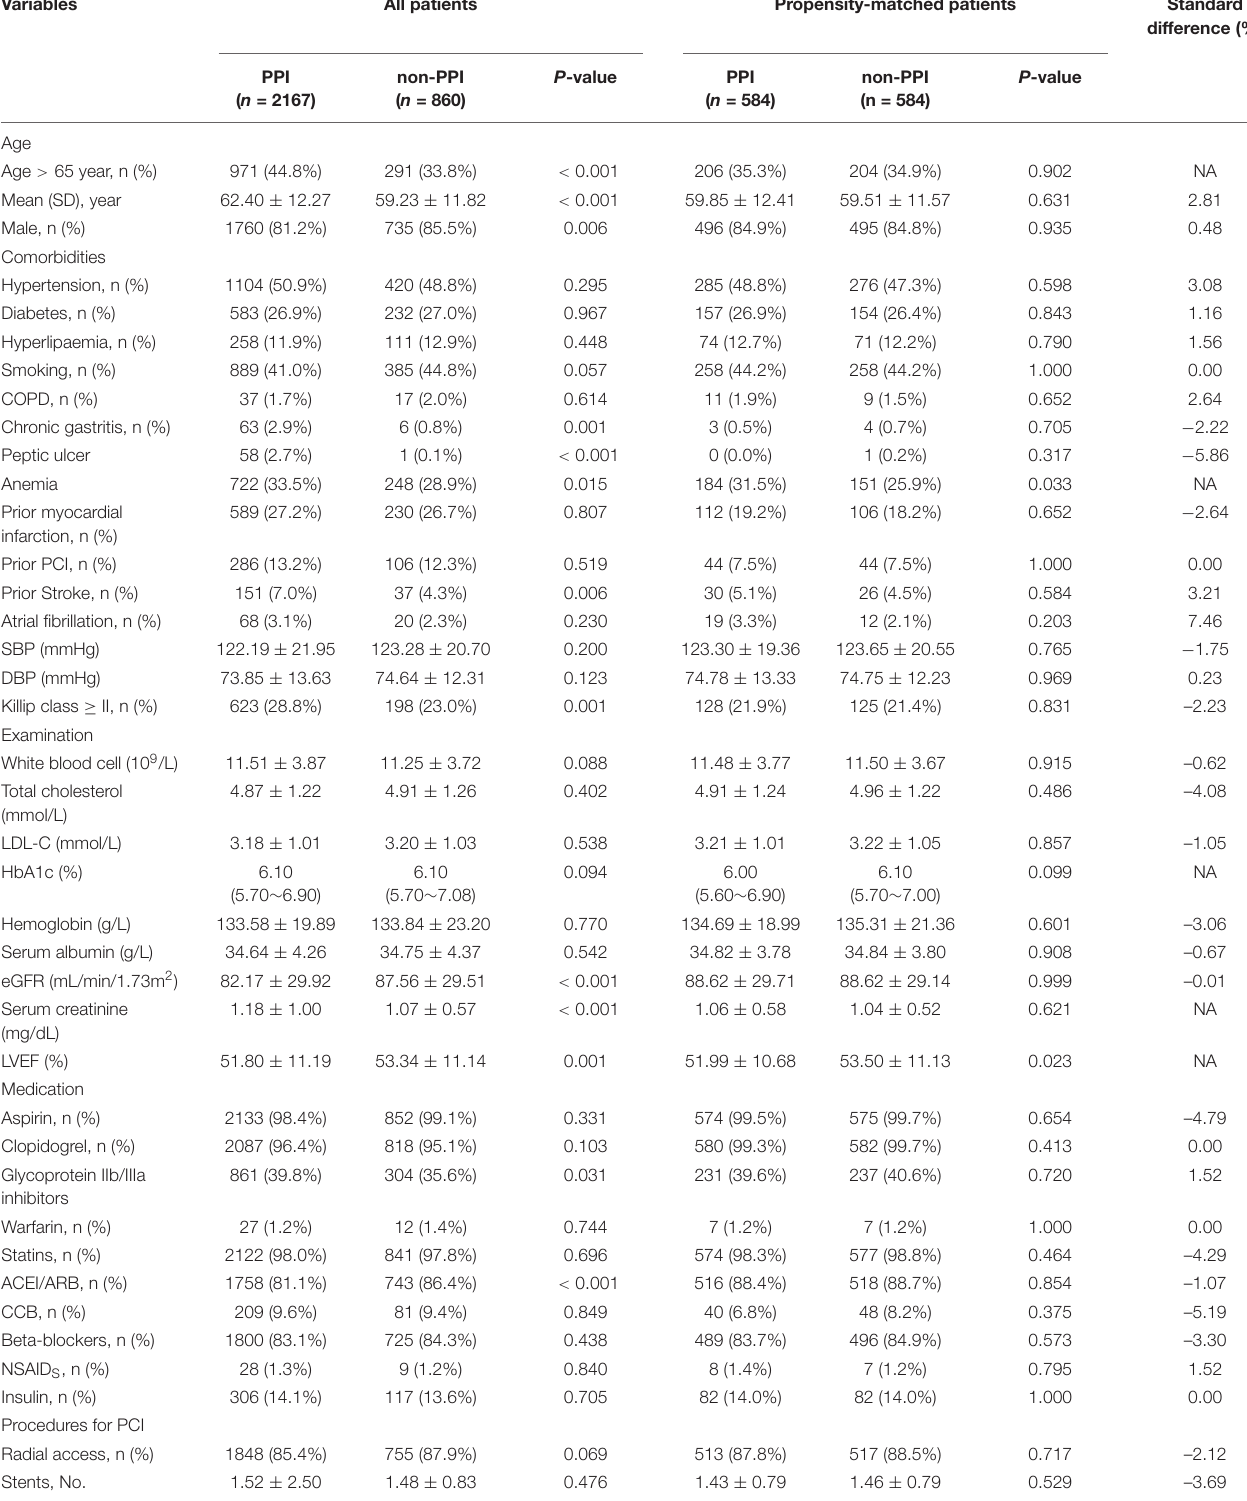
TABLE 1 | Differences in baseline characteristics between patients with and without proton pump inhibitor treatment. Variables All patients Propensity-matched